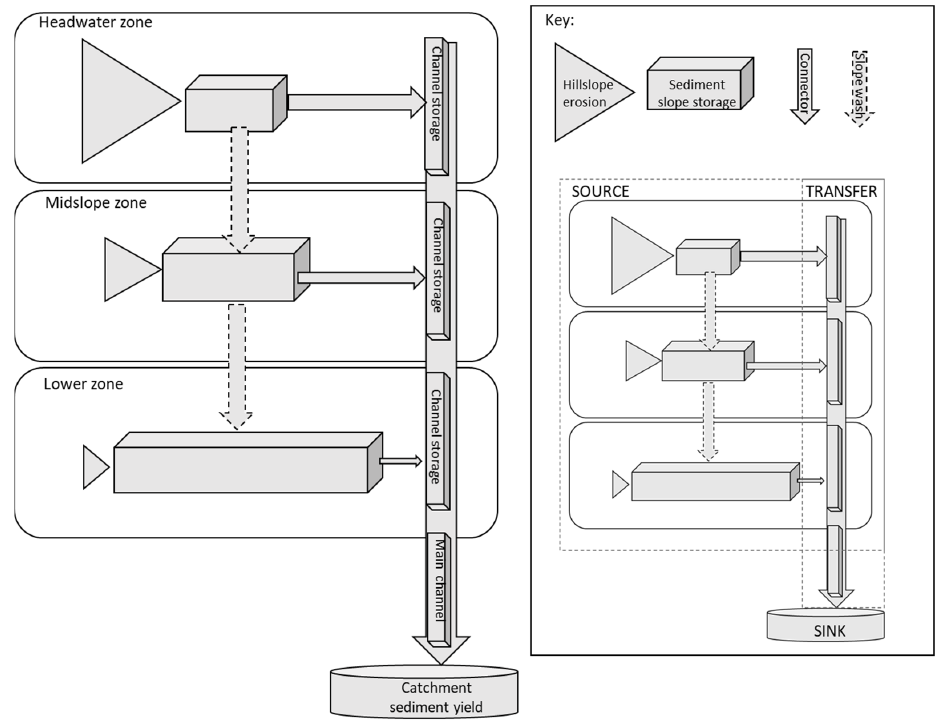
Figure 1. A conceptualisation of the erosion and sediment yield model, indicating the two types of storage in each catchment zone and the movement of sediment between zones along a longitudinal profile.